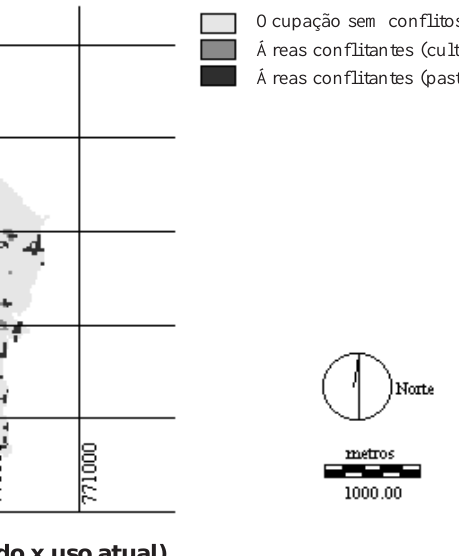
Figura 4. Mapa de adequação de uso (uso adequado x uso